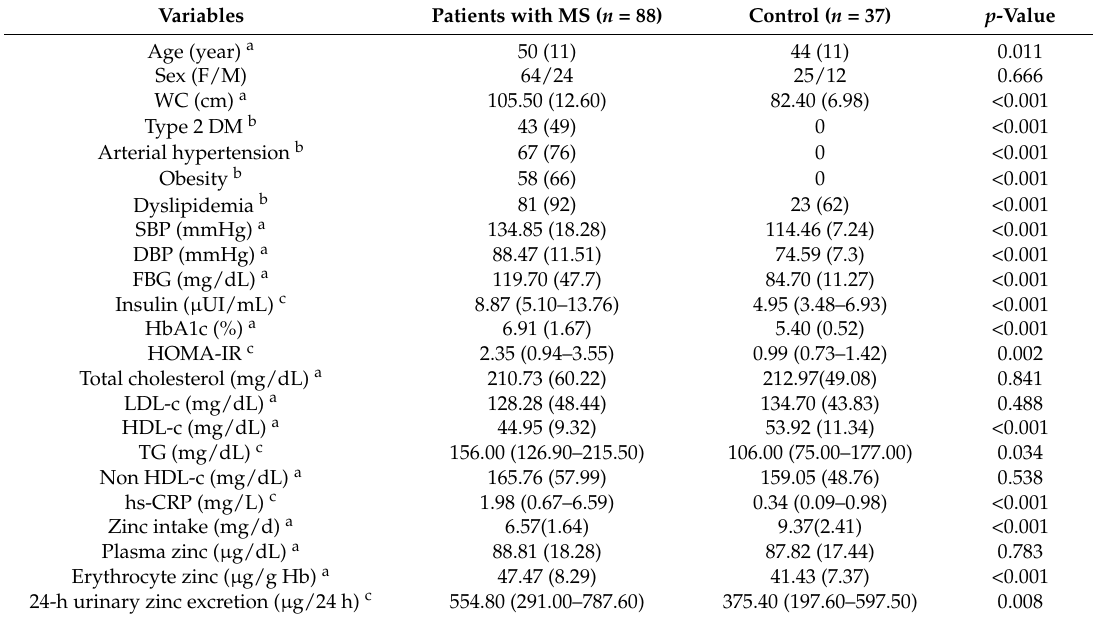
Table 1. General characteristics, metabolic profiles, and zinc biomarkers. MS: metabolic